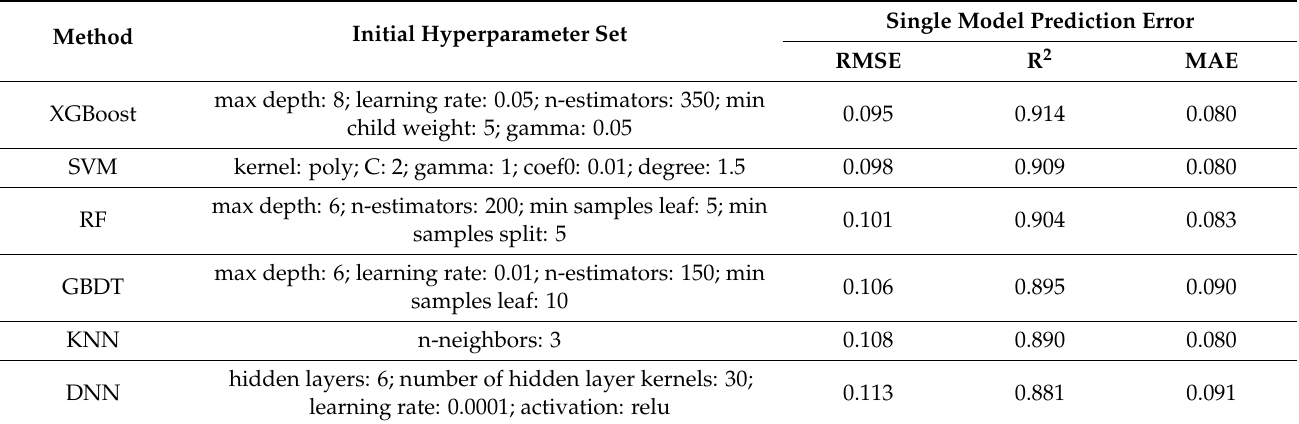
Table 2. Hyperparameter settings and prediction errors of XGBoost, SVM, RF, GBDT, KNN and DNN. Method